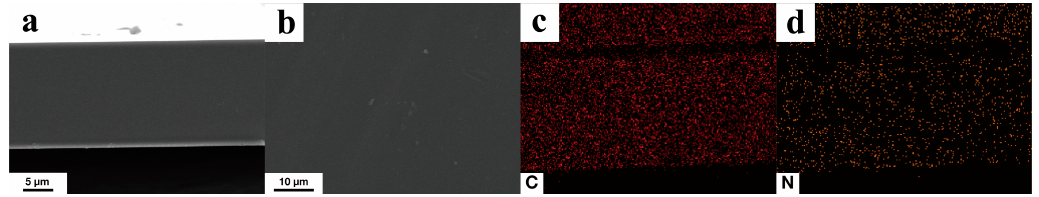
Figure 5. ( a ) Cross − sectional morphology, ( b ) surface morphology, ( c ) C distribution, and ( d ) N distribution in the same region of the Nafion/1.0 wt.% g − C 3 N 4 modified membrane.